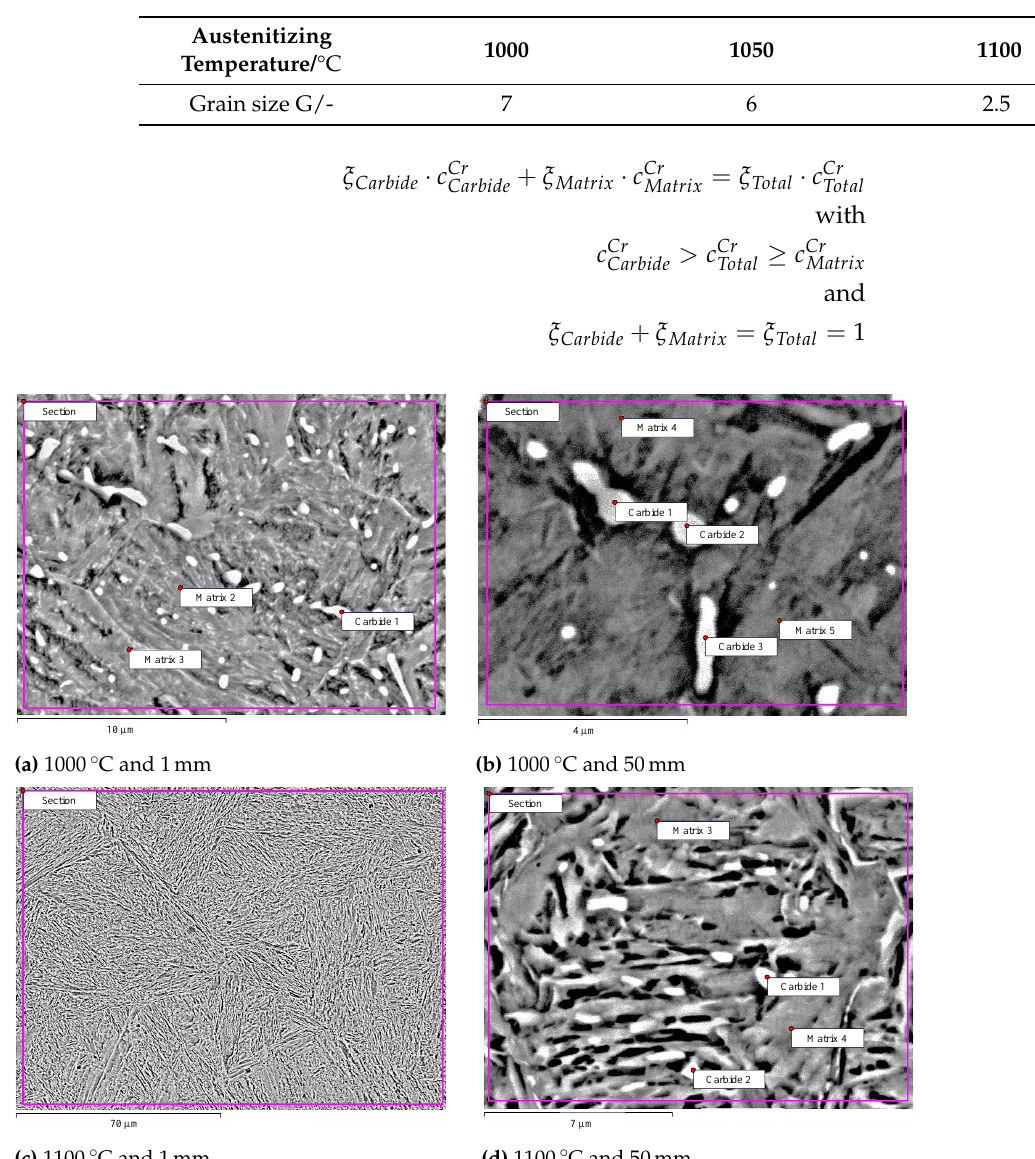
Figure 18. Selected microstructures of X30Cr13 used for EDX Analysis with SEM as a function of the austenitizing temperature and the distance from the quenched end face and thus the cooling rate: ( a ) 1000°C and 1mm, ( b ) 1000°C and 50mm, ( c ) 1100°C and 1mm, and ( d ) 1100°C and 50mm. The different measuring points are marked and named. The analyzed sections are framed in pink.